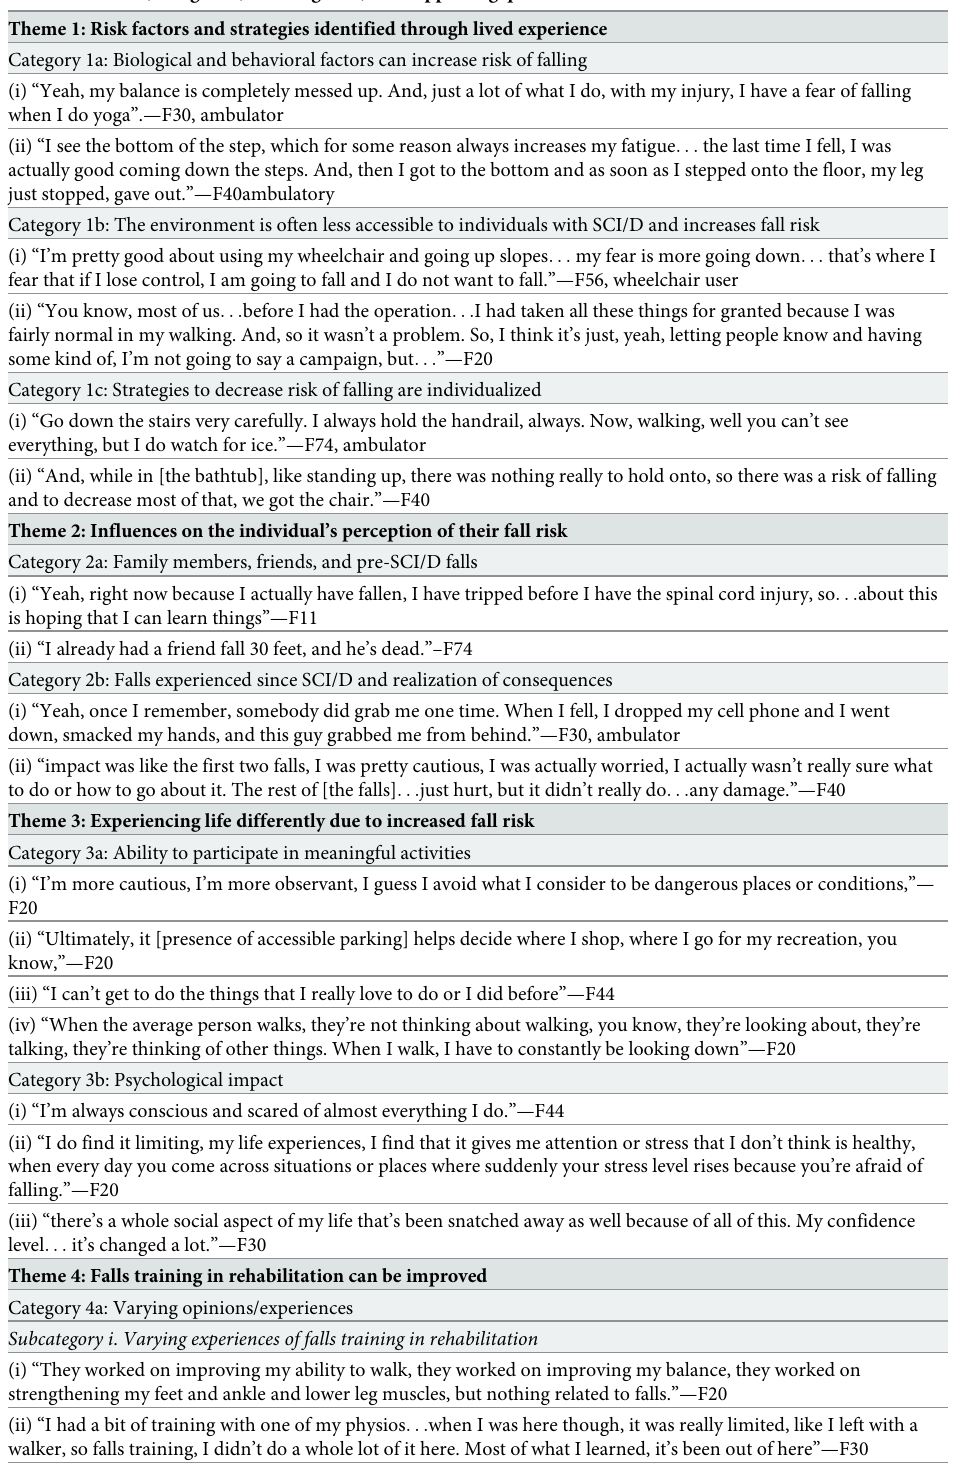
Table 2. Themes, categories, subcategories, and supporting